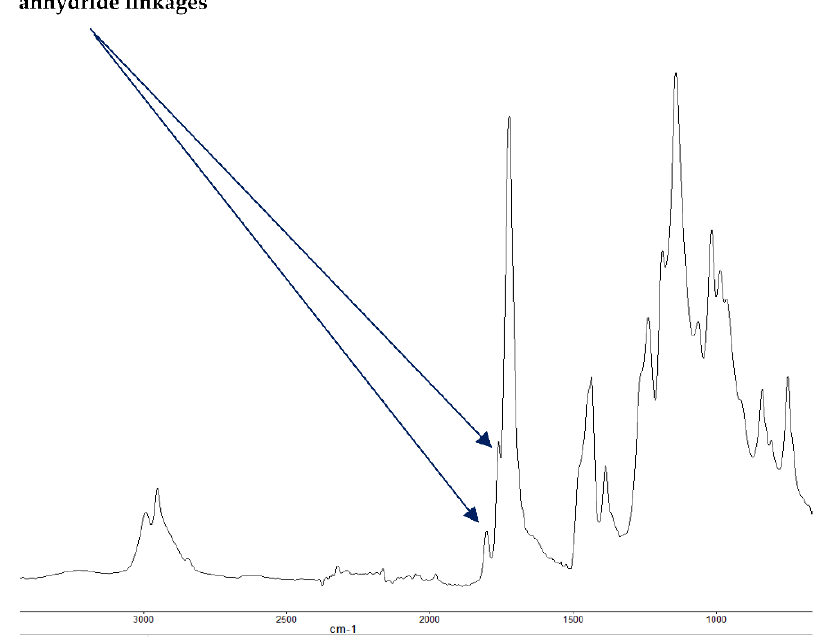
Figure 4. FT-IR spectrum of PMMA + DE-1-AEP (partially burnt sample).